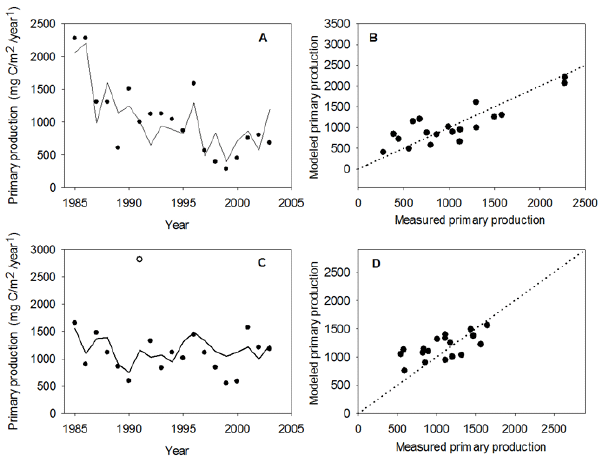
(lines): (A) Chl a concentrations; (B) mussel biomass in shallow water (≤ 2 m), and (C) mussel biomass in deep water (>2 Fig. 3 . Time series of observed values (dots) and modeled values (lines, multiple linear regression) for area phytoplankton primary production in Skive Fjord for: (A) January through June and (C) July through December. The equations for the multiple linear regression models are: For January through June: P (months 1-6) = 0.82 P loadings - 0.096 Salinity - 0.52 a Wind³ - 0.15 radiation. For July through December: P (months a 7-12) = 0.26 N loadings - 0.69 NAO index - 0.38 Wind³. The coefficients are relative coefficients for data normalized to zero mean and a standard deviation of 1. Relationships between observed and modeled values for months 1 through 6 and month 7 through 12 are shown in B and D, respectively; 1991 is considered an outlier in C. Lines represent 1:1 ratio between measured and model values.